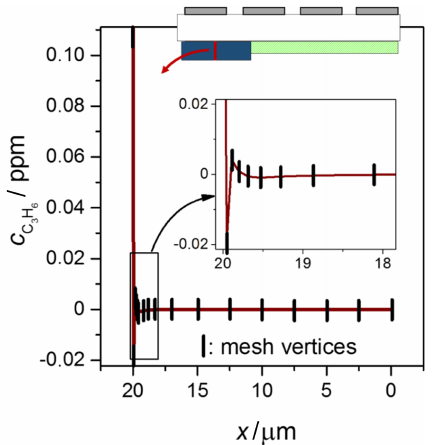
Figure 4. Calculated propene concentration for a minimum of mesh elements evaluated on the red line through the thickness of the cat- alytically activated layer. A negative concentration is calculated be- cause of the high reaction rate and too few mesh elements. The scheme at the top illustrates where the concentration is